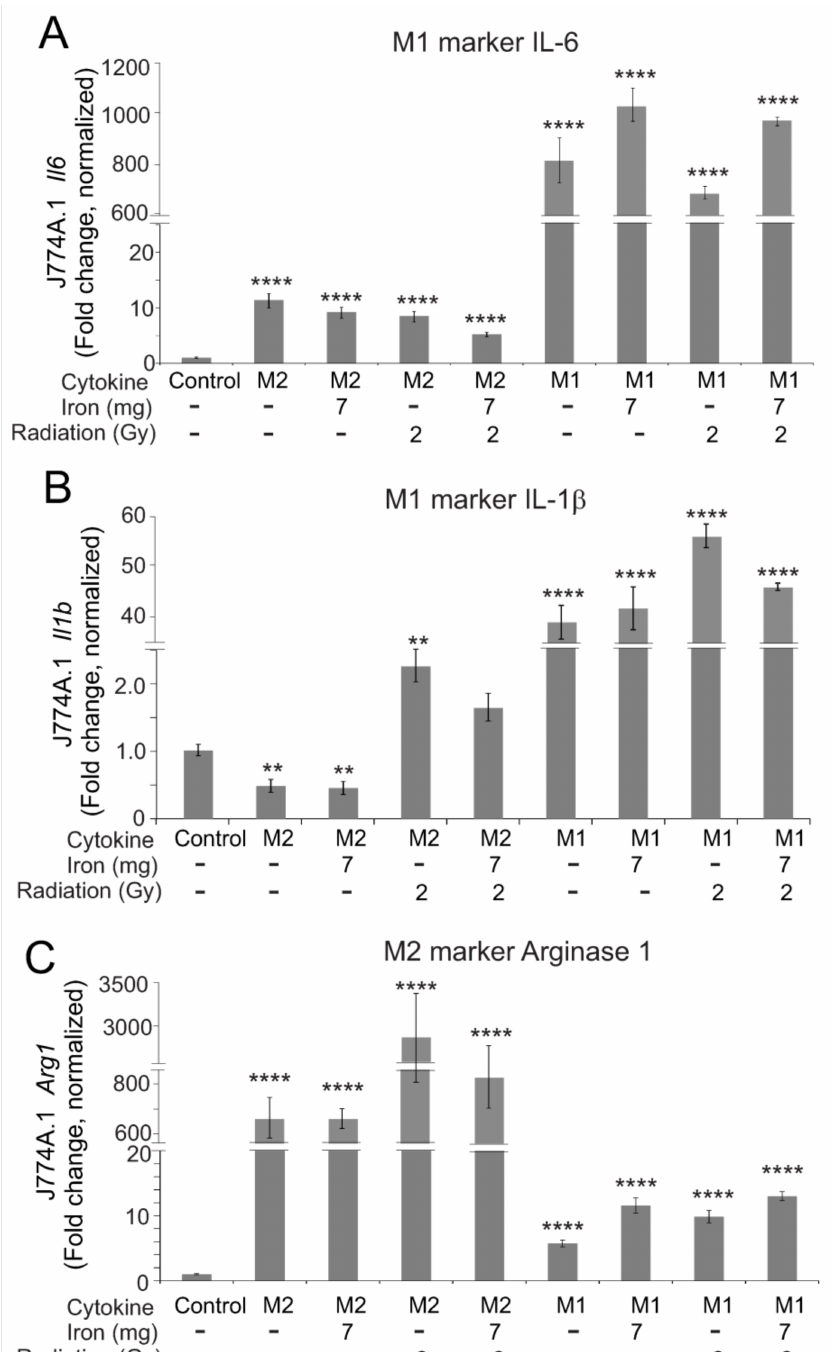
Figure 10. Effects of radiation and high iron concentrations on J774A.1 murine macrophage po- larization by cytokines in culture. J774A.1 cells were grown to ~80% confluence, and untreated (control) exposed to either 7 or 12 mg/L Fe 3+ and/or 2 or 6.85 Gy X-ray irradiation. 1 h after treat- ments, cells were treated with 100 ng/mL IL-4 to induce M2 or 100 ng/mL IFN- γ + 100 ng/mL LPS to induce M1. As a control for M2 and M1 polarization, cells were treated with IL-4 or IFN- γ + LPS with no pretreatment. 24 h post-irradiation, RNA was purified. qPCR was performed for M1 markers ( Il6 ( A ) and Il1b ( B )), and an M2 marker ( Arg1 ( C )). Gene expression was normalized to Gapdh, and fold increase was calculated relative to untreated cells (control). Graphs show means ± SEM, n = 3 independent experiments. Asterisks: ** indicates p < 0.01 from control; and **** indicates p < 0.0001 from